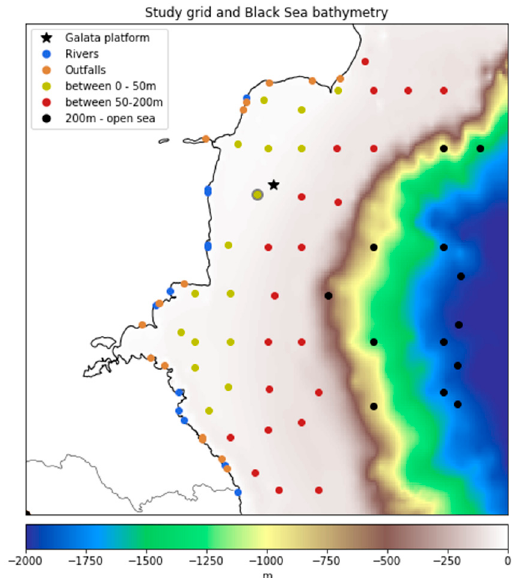
Figure 1. Bathymetry of the study area with grouping of the sites according to their source type and depth. Each point represents the area of ~30,000 m 2 for the river and outfall points and ~170,000 m 2 for the inwater points. The black star marks the coordinates of the Galata AERONET-OC site. The choice of the coordinates and distribution of the study points was made as